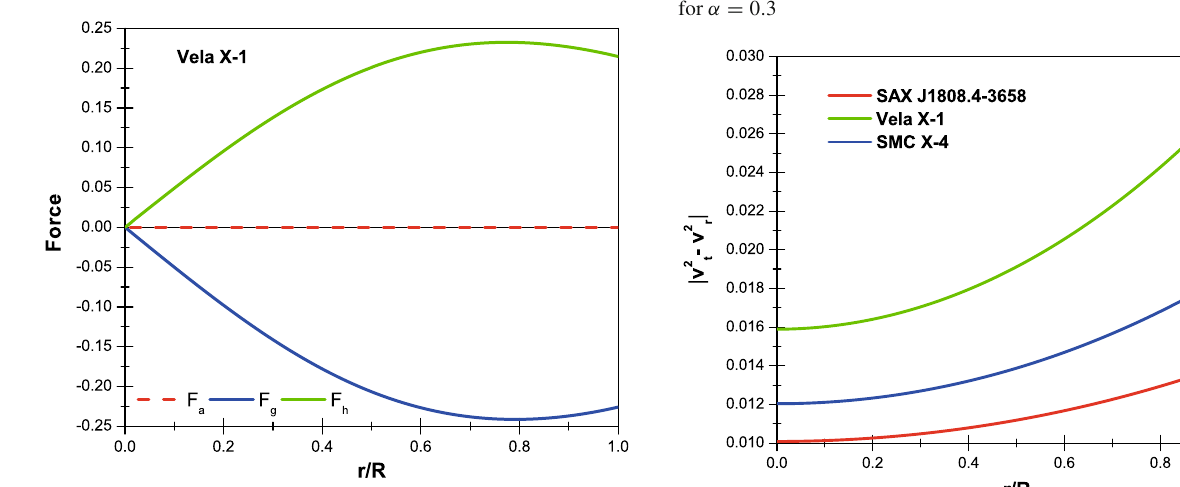
Fig. 20 Variation of the absolute value of square of sound velocity with respect to fractional radius corresponding to α = 0 .